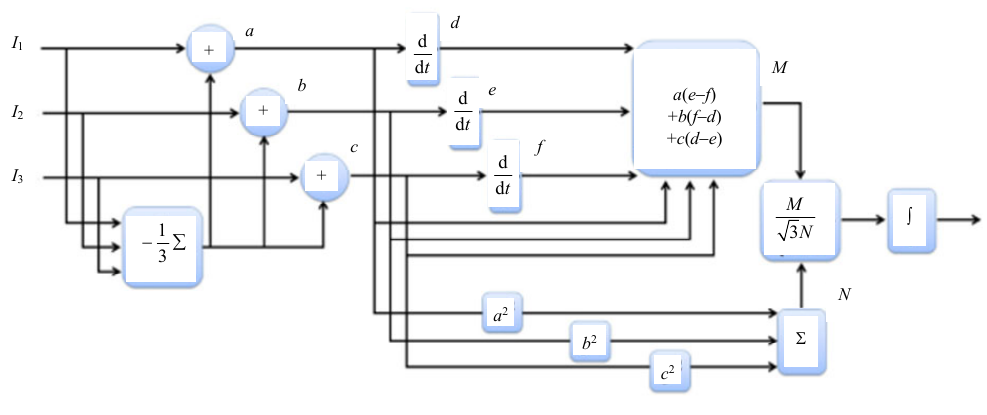
Fig. 10 Demodulation system based on the 3×3 coupler [51].